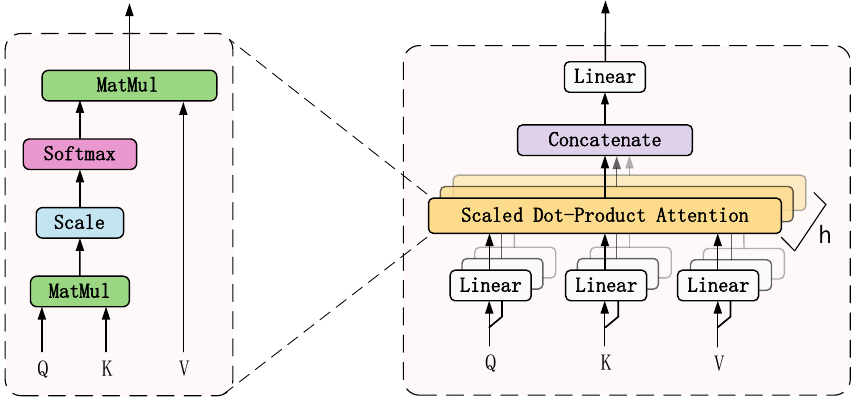
Figure 6. The architecture of multilayer attention